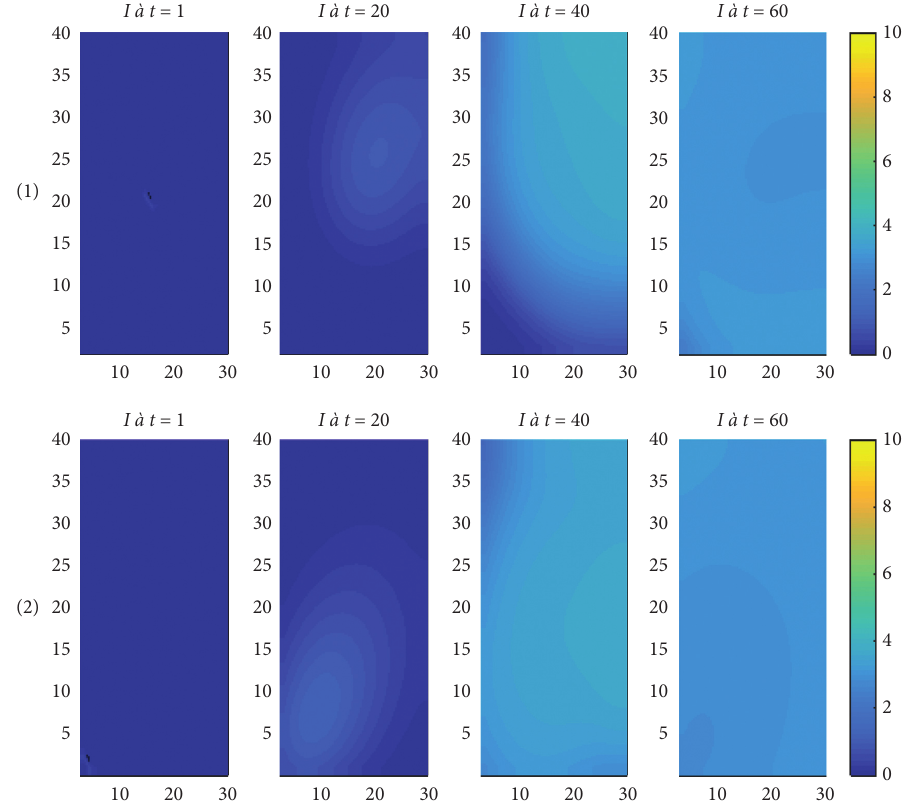
Figure 9: Infected behavior within Ω without control (vaccine strategy starts from the first day).